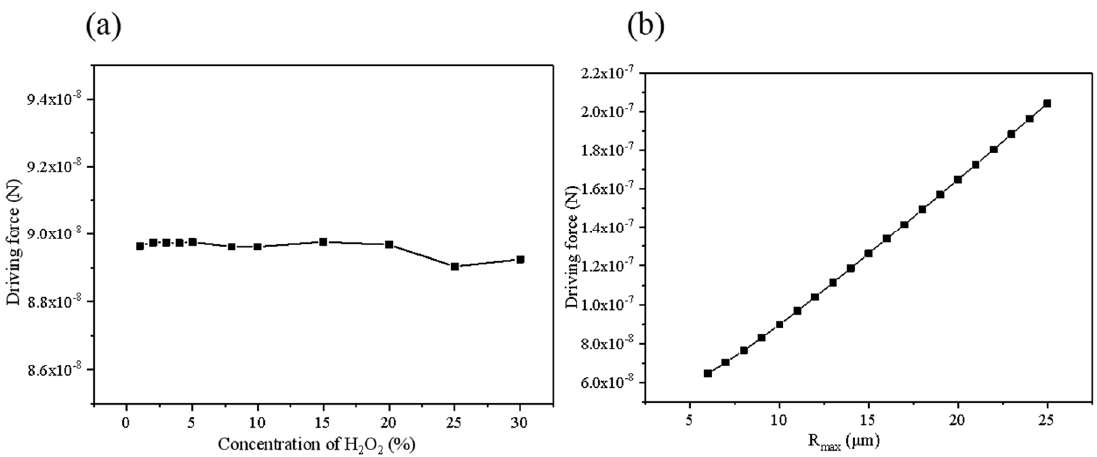
Figure 9. Relationship between driving force and ( a ) concentration of hydrogen peroxide C H2O2 and ( b ) opening radius.